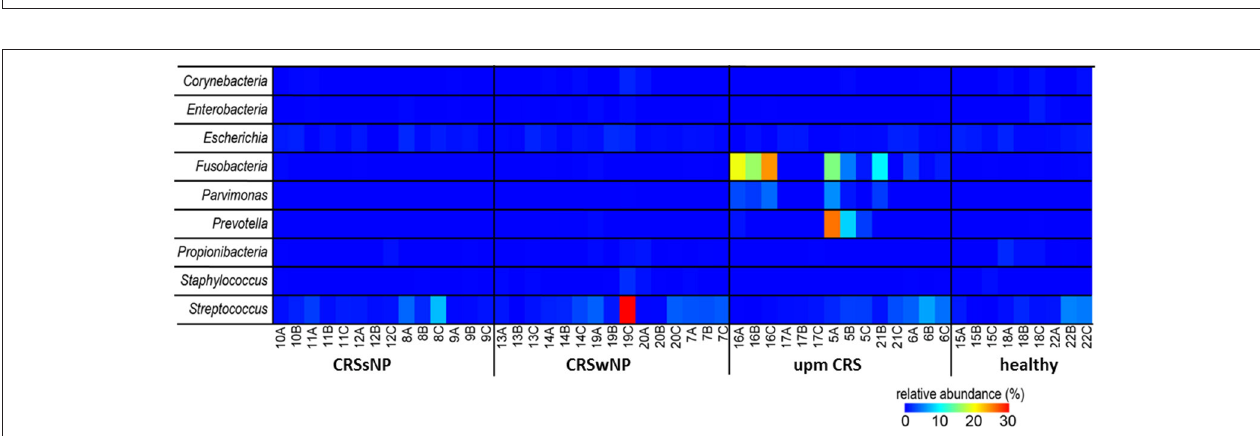
FIGURE 4 | Relative abundance of the significantly enriched bacterial genera in CRS without nasal polyps identified by the LefSe analysis. The samples were ordered based on the different CRS types: unilateral purulent maxillary CRS (upm CRS), CRS with nasal polyps (CRSwNP), and CRS without nasal polyps (CRSsNP). For detailed information of each sample refer to Table 3 .